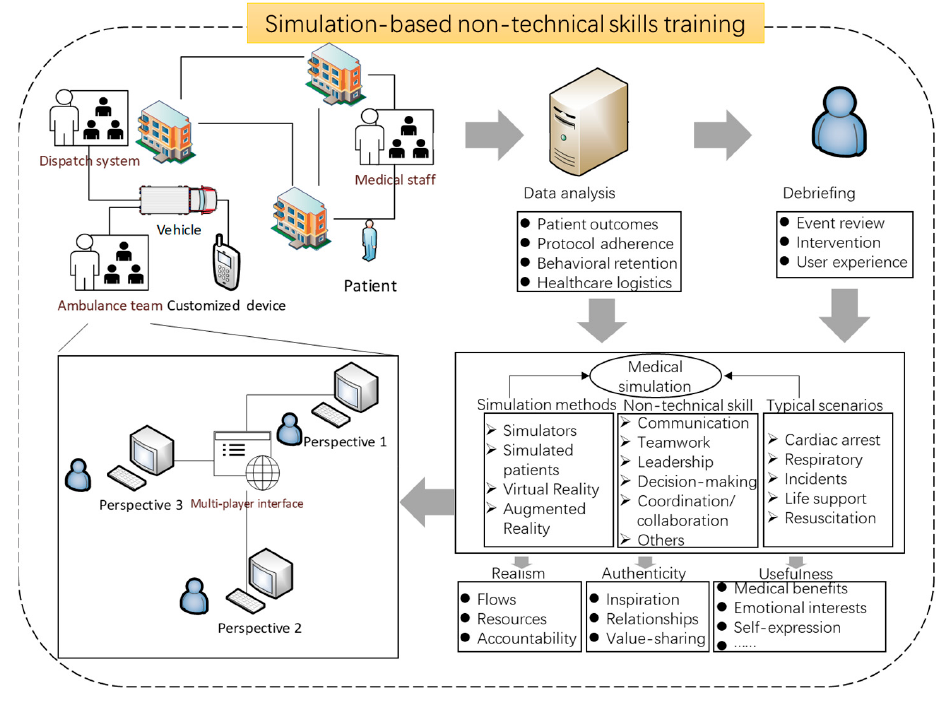
Figure 9. Ring model in the intersection between medical simulation, non-technical skills training and emergency medicine.